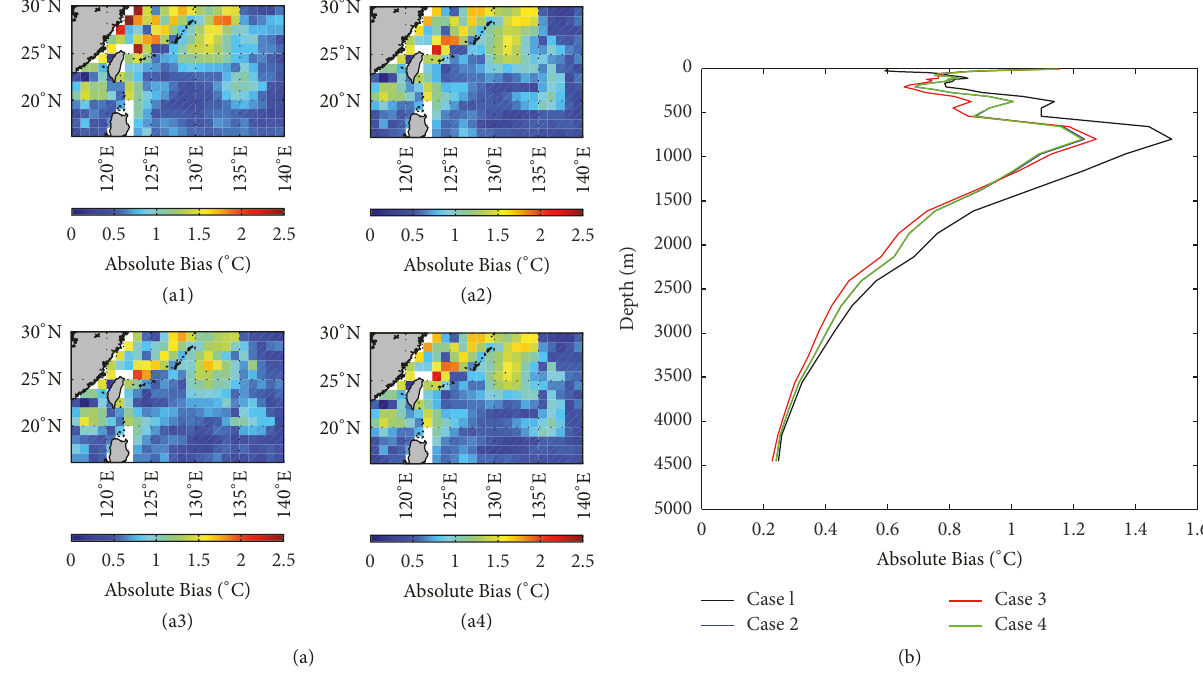
Figure 6: HAB (a) and VAB (b) of experiment result compared with EN4: symbols (a1)–(a4) are the HAB of cases 1–4, respectively.